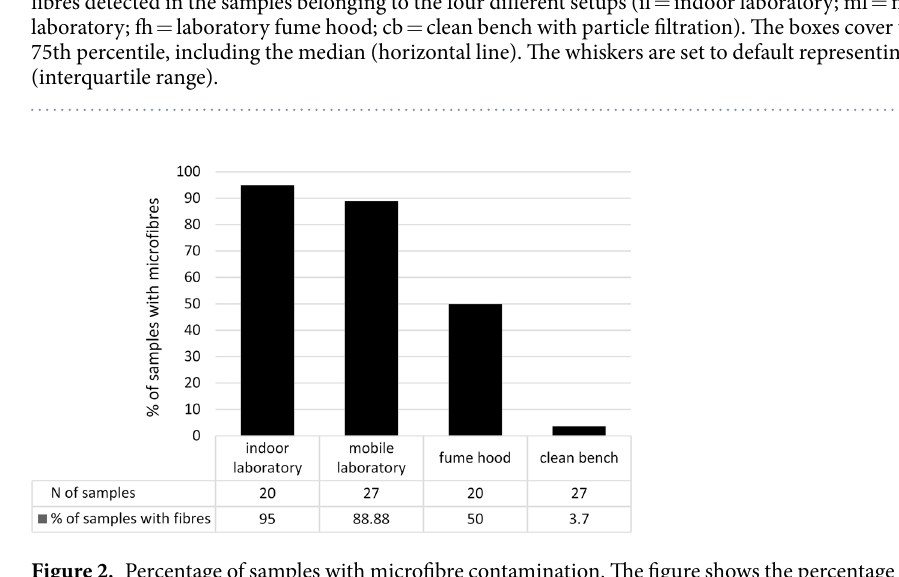
Figure 2. Percentage of samples with microfibre contamination. The figure shows the percentage of samples found with microfibre contamination indoor, in the mobile laboratory, the fume hood and on the clean bench with particle filtration. The number of samples exposed to the four different setups are represented as well. The entire list of samples exposed to the different setups can be found as Supplementary Tables S1 and